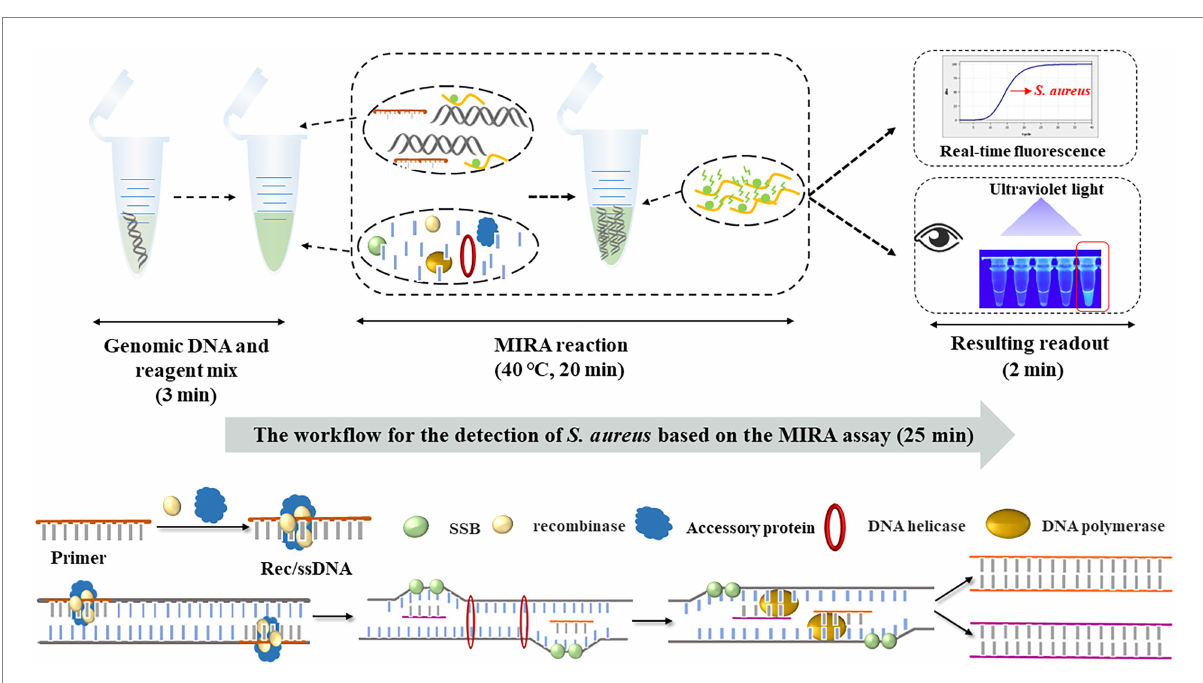
FIGURE 4 The workflow and schematic mechanism of S. aureus based on MIRA. S. aureus -MIRA assay contains three steps: mixing of genomic DNA and reaction reagents, MIRA reaction, observation of test results. The whole diagnosis procedure can be completed in 25